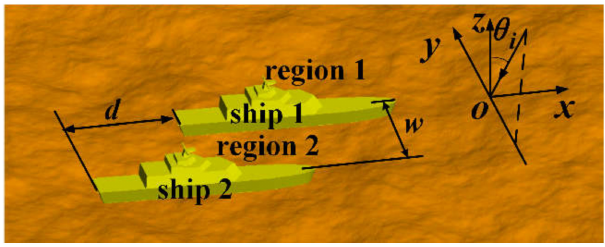
Figure 9. Composite marine scene containing two ships.